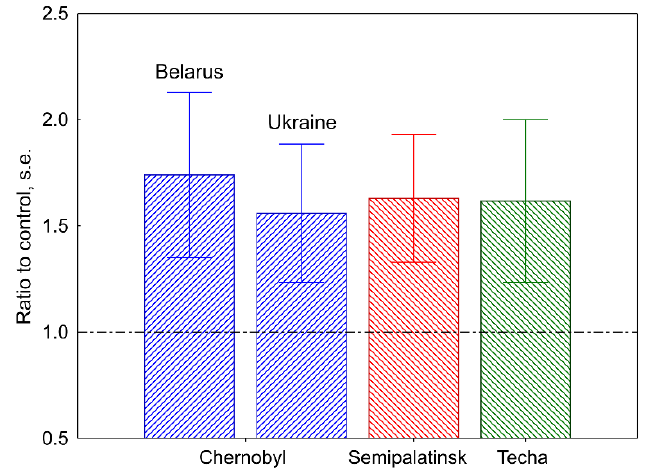
Figure 1. The mini satellite mutation rate in the germline of human families accidentally exposed to ionizing radiation. Data from References [8–12].